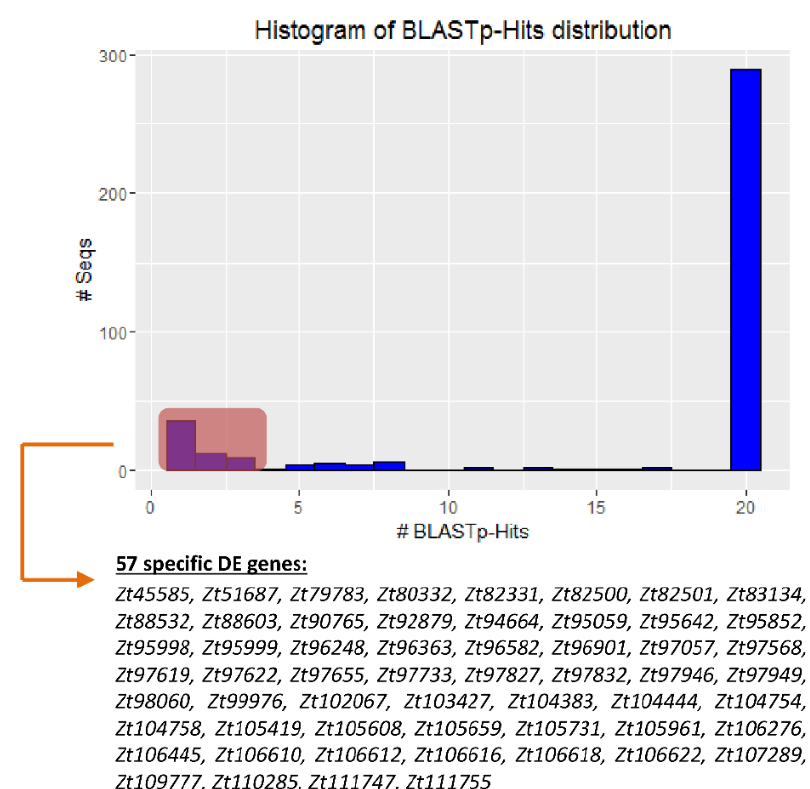
Figure 5. Histogram indicating the distribution of the BLASTp hits of DE genes. The predicted amino acid sequences of the 375 DE genes from the RNA-Seq analysis were searched by using the NCBI “nr”-database to identify potential homologs. Gene products with just 1, 2 or 3 orthologues in other fungal species were considered as potentially “unique” or “ Z. tritici -specific”, and thus represent attractive candidate genes for further